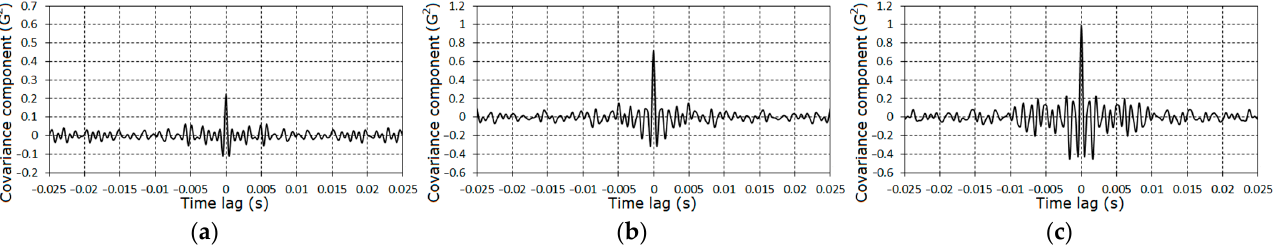
Figure 18. The dependences of the zero th covariance component estimators on the time lag for the first ( a ), second ( b ), and third ( c ) stages.